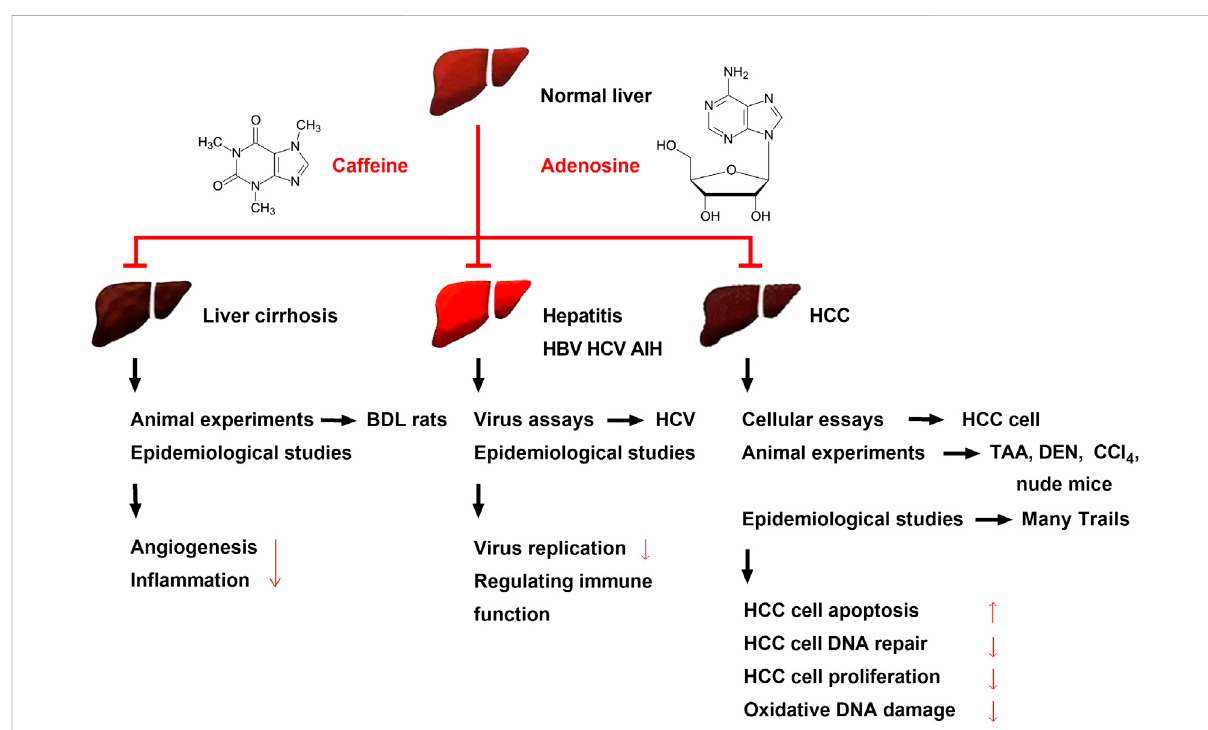
FIGURE 3 Effects of caffeine on alleviating liver cirrhosis, different types of hepatitis, and HCC and its possible mechanisms. Caffeine attenuates BDL- induced liver cirrhosis in rats. Several clinical trials have shown the same result, and the mechanism may be related to the ability of caffeine to inhibit in fl ammation and angiogenesis. Viral assays have found that caffeine can inhibit HBV and HCV, while clinical trials have found that caffeine can alleviate hepatitis B, C, and AIH; its mechanism may be related to the inhibition of hepatitis virus replication and regulation of immune function. Recent preclinical studies and multiple clinical trials have found that caffeine attenuates HCC. Caffeine inhibits the proliferation of various HCC cells and attenuates chemical toxicant (TAA, DEN, and CCl 4 )-induced HCC and xenograft HCC in nude mice. Large clinical trials initiated in several countries have found that the risk of HCC is reduced in people with an oral coffee consumption habit; this may be due to the ability of caffeine to inhibit HCC cell proliferation and oxidative DNA damage and reduce HCC cell DNA